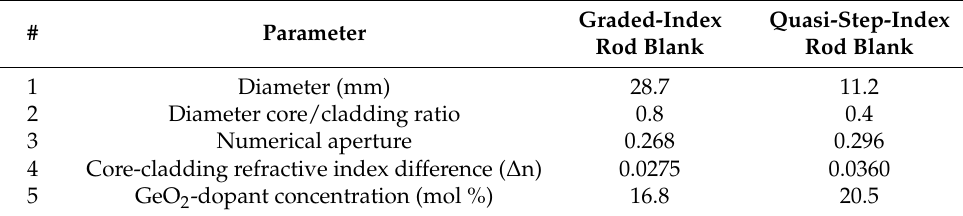
Table 1. Geometrical and optical parameters of rod blanks.